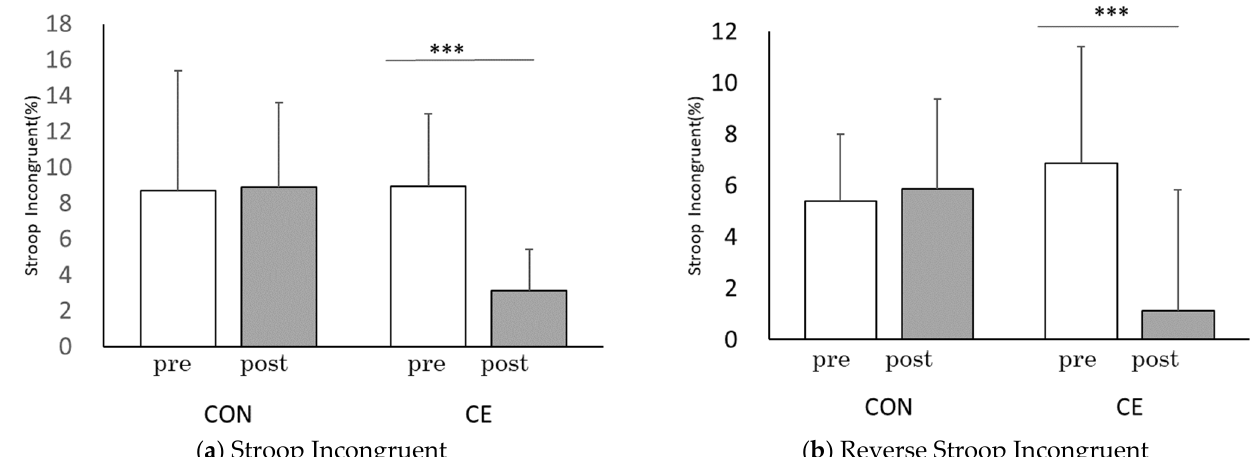
Figure 5. Comparisons of each trial between pre and post Co-kara exercise: Stroop test; ( a ) ST interference rate, ( b ) Reverse-ST interference rate. CE: Co-kara exercise experiment; CON: Control experiment; pre: before Co-kara exercise; post: after Co-kara exercise. ( n = 9), *** p < 0.001. ( a ) Significant difference between pre and post, CE; ( p = 0.000, r = 0.92), CON; n.s. (not significant, p = 0.88, r = 0.19). ( b ) Significant difference between pre and post, CE; ( p = 0.021, r = 0.71), CON; n.s. (not significant, p = 0.723, r = 0.13).